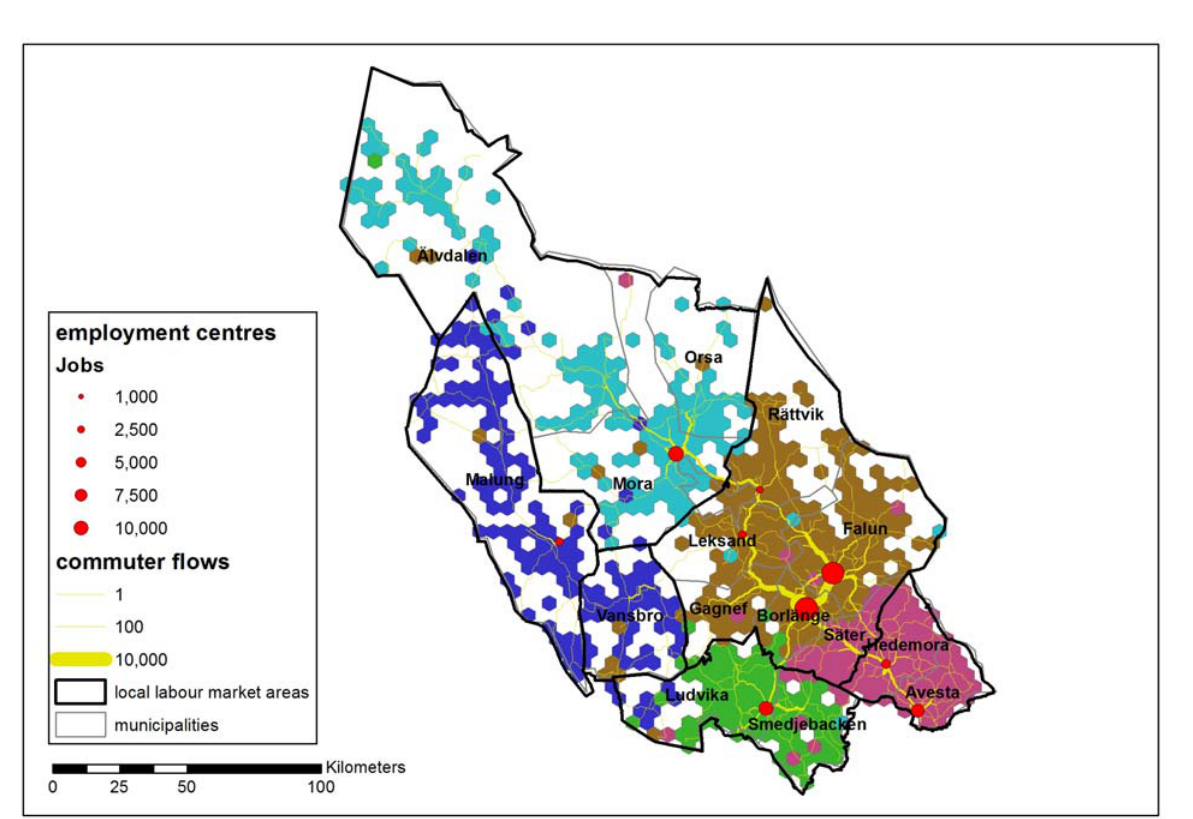
Figure 13. Intramax analysis result at step 671 (five regions) compared with local labor market